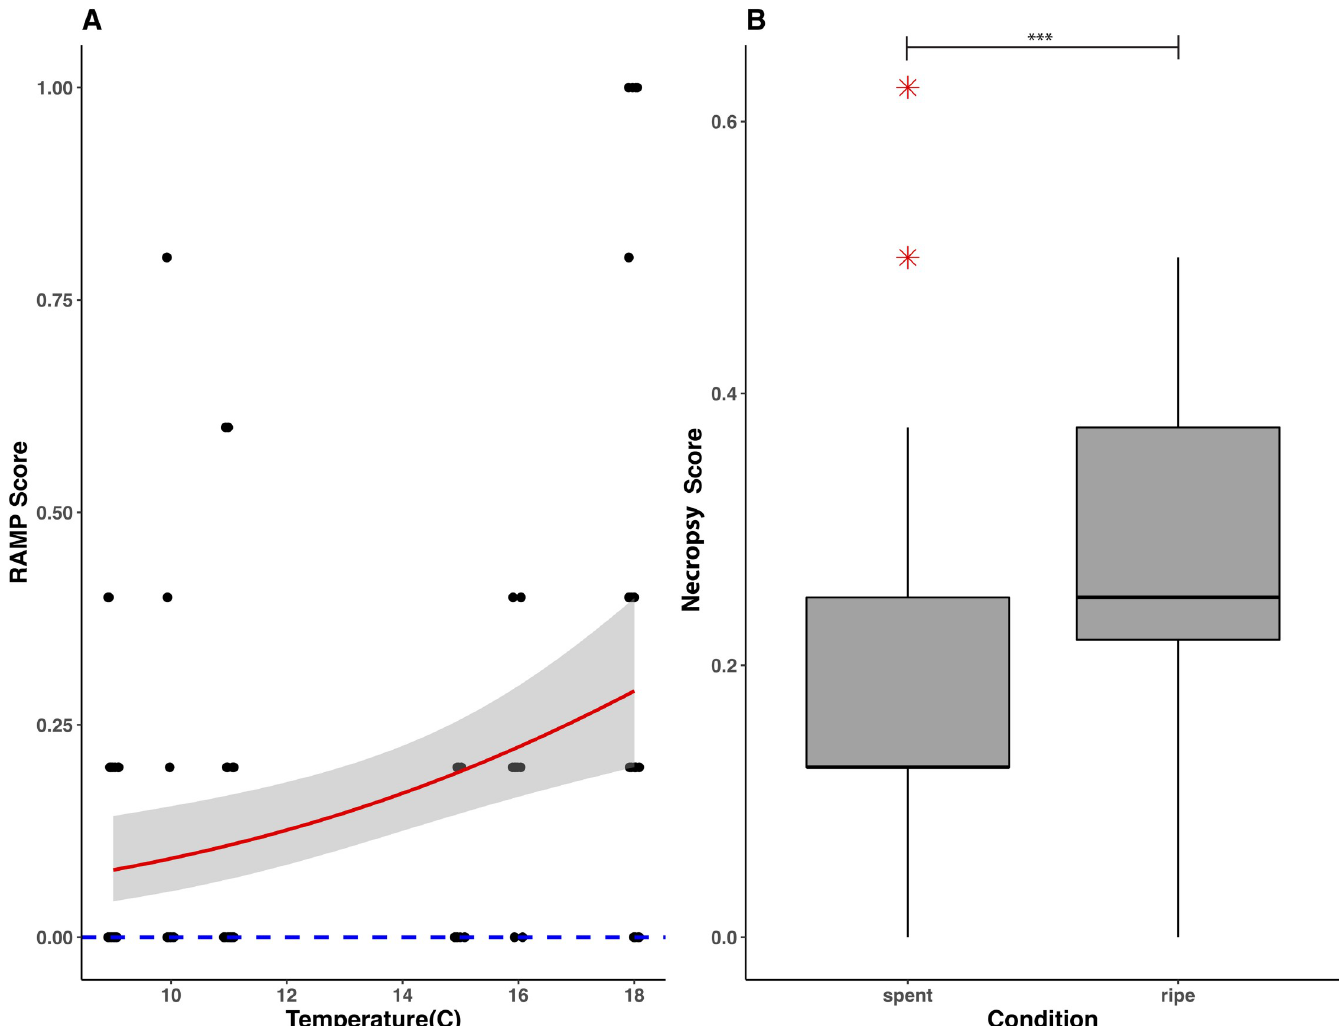
Fig 6. (A) Change in RAMP scores as a function of water temperature during tagging. Red line represents general linear regression with quasibinomial error distribution and 95% confidence intervals. Zero-intercept shown by the dashed blue line. (B) Boxplots showing median and quartile range of physical impairment scores for pre and post-spawned alewives, with whiskers at 1.5 IQR of the upper/lower quartiles. Outliers are shown in red. ��� P < 0.001